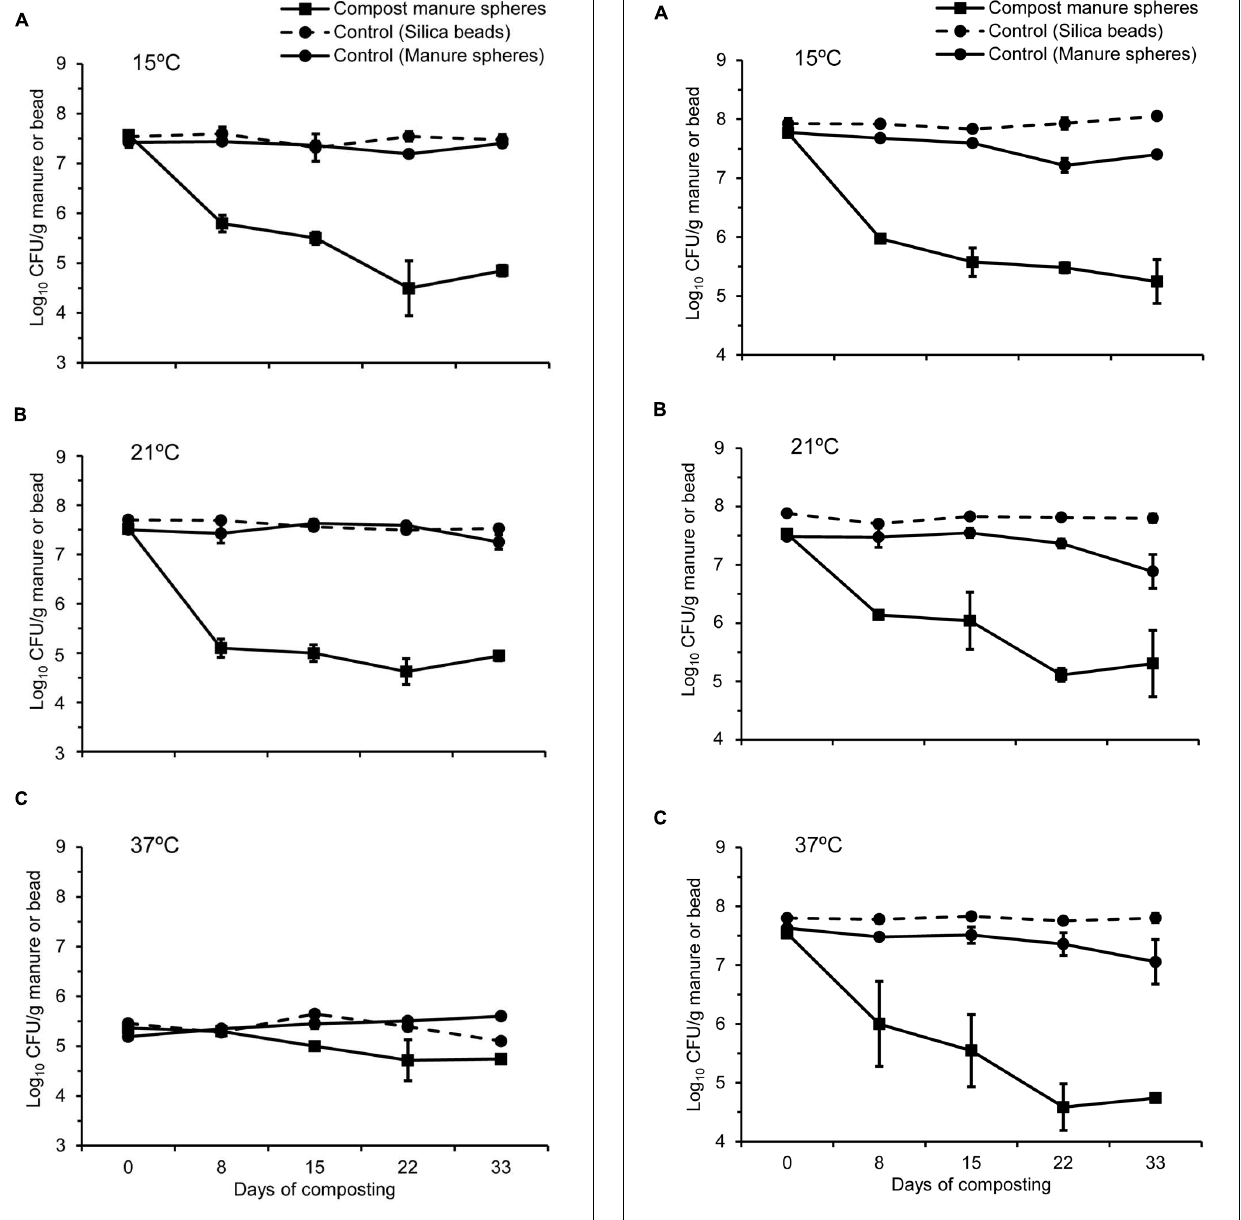
FIGURE 3 | Survival of B. thuringiensis spores (Log 10 CFU g − 1 manure) generated at different temperatures (A) 15 ◦ C, (B) 21 ◦ C, and (C) 37 ◦ C and placed in manure spheres that were composted with feedlot cattle manure for 33 days. For controls, silica beads and fresh manure spheres were inoculated with B. thuringiensis spores and kept at room temperature over 33 days.